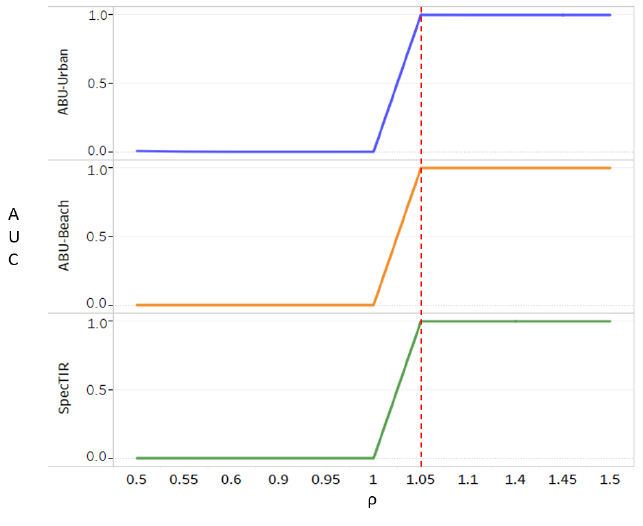
Figure 8. Tuning ρ of the proposed LRSNCR.